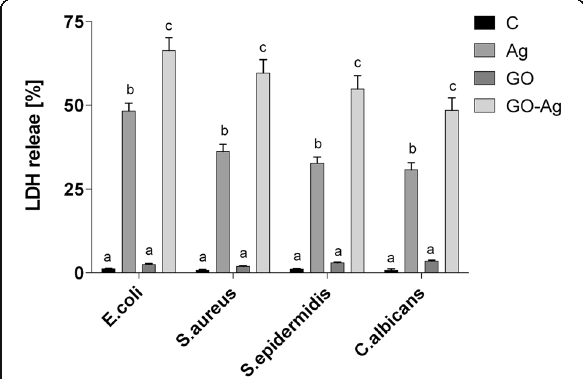
Fig. 12 Foils coated with nanomaterials decreased E . coli , S . aureus , S . epidermidis , and C . albicans membrane integrity. Membrane integrity of bacteria and yeast after incubation on foils coated with Ag-NPs, GO, and GO-Ag at 37 °C for 24 h was assessed with LDH assay. C control group (foil without nanoparticles), Ag foil coated with silver nanoparticles, GO foil coated with graphene oxide, GO-Ag foil coated with composite of graphene oxide and silver nanoparticles. Note: The columns with different letters (a – c) indicate significant differences between the concentrations ( P = 0.000); error bars are standard deviations